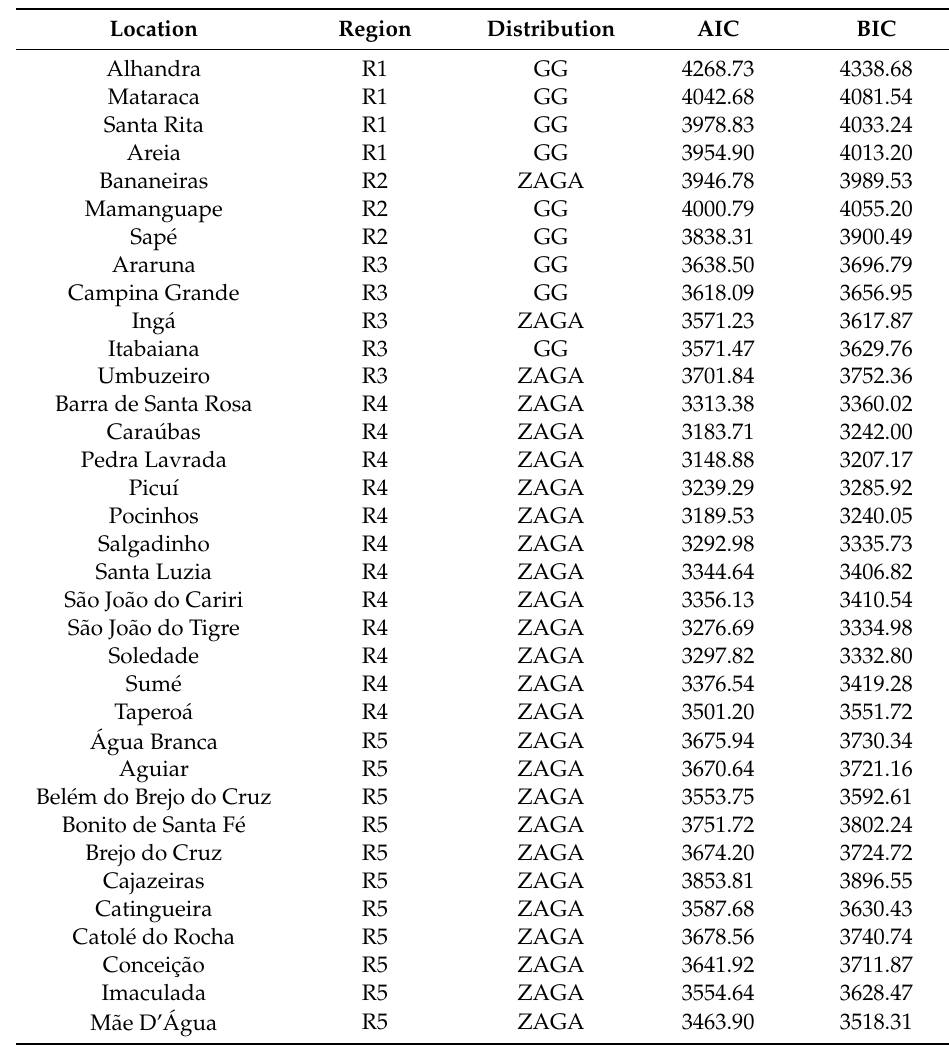
Table 4. Selection of Generalized Additive Models for Location, Scale and Shape (GAMLSS) by Akaike Information Criterion (AIC) and Bayesian Information Criterion (BIC) criteria corresponding to each study